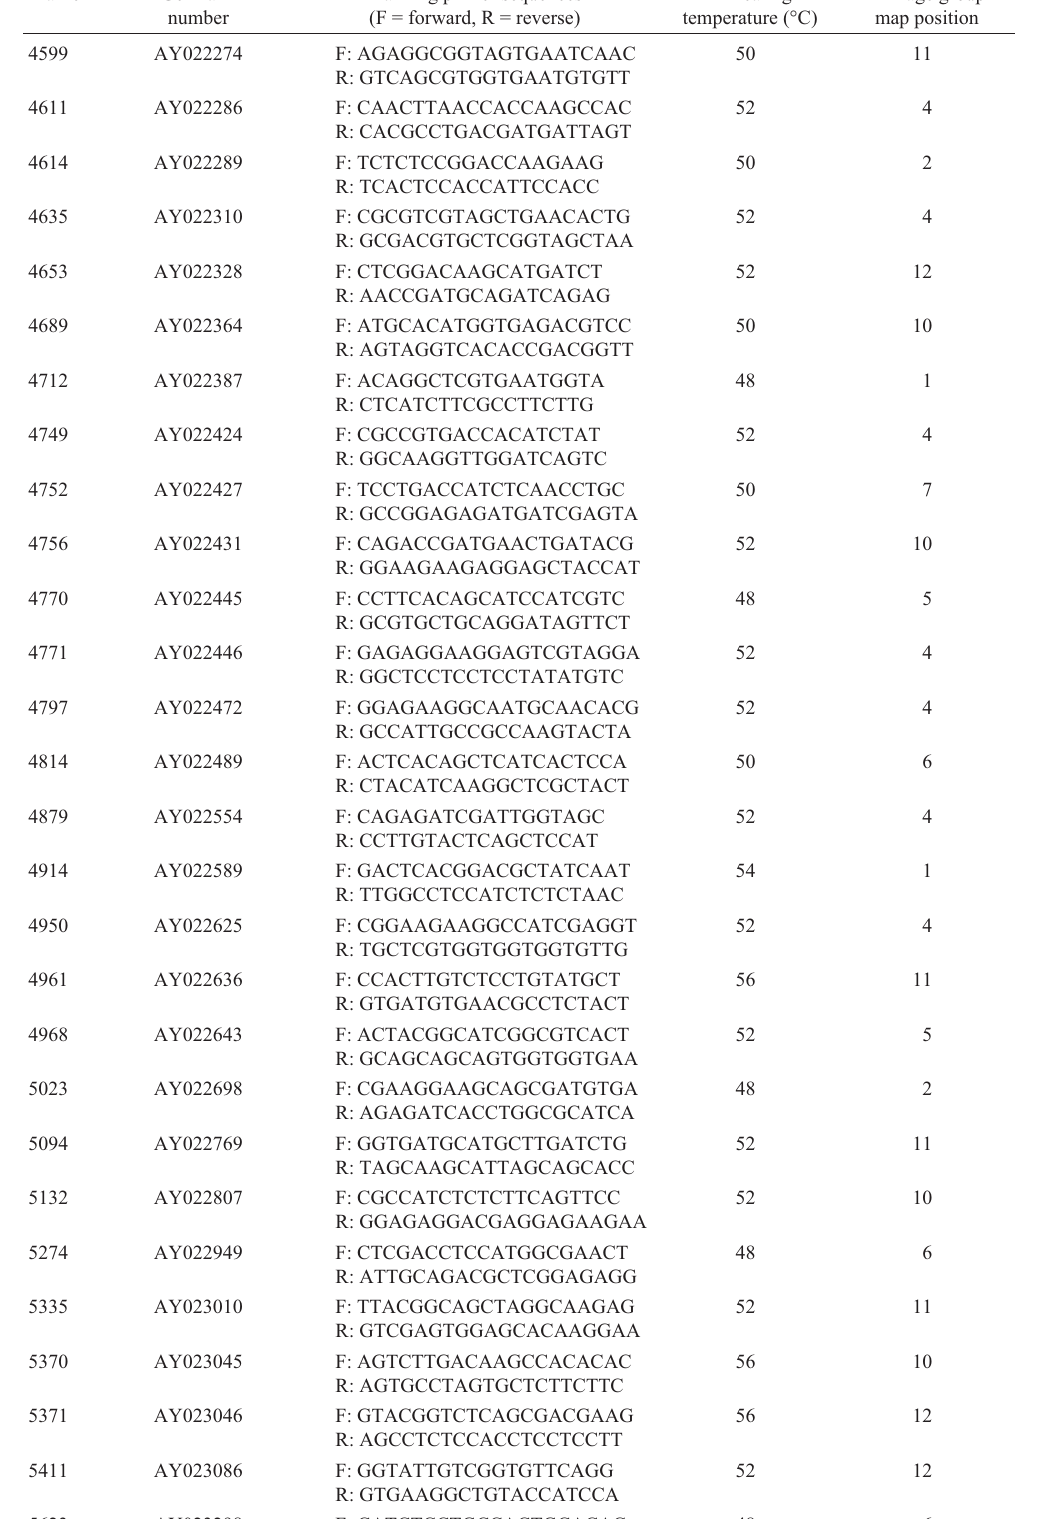
Table 1 - Microsatellite markers based on tri-nucleotide repeats obtained from sequences available on public databases that showed polymorphism between the Oryza glumaepatula and Oryza sativa parents.